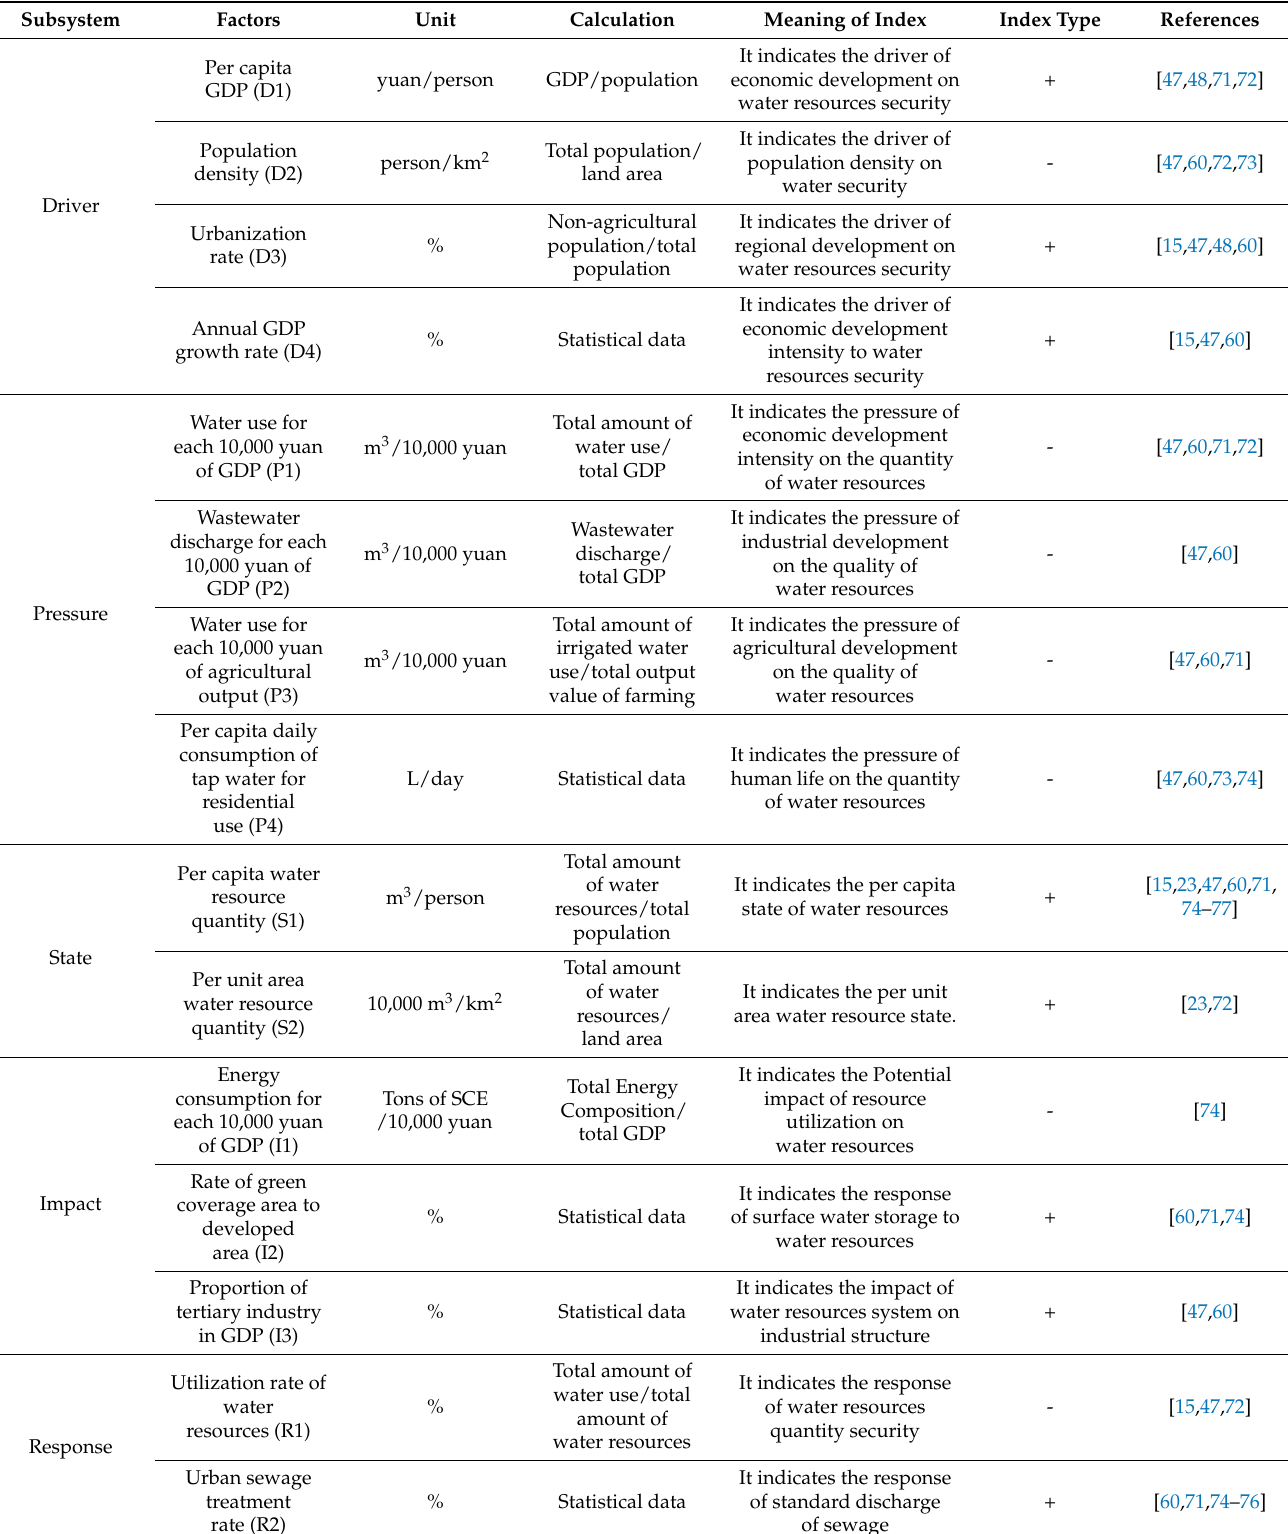
Table 1. Social economic factors used in the DPSIR system. Here, index type “+” indicates that higher values are more desirable for the particular factor whereas “-” indicates that lower values are more